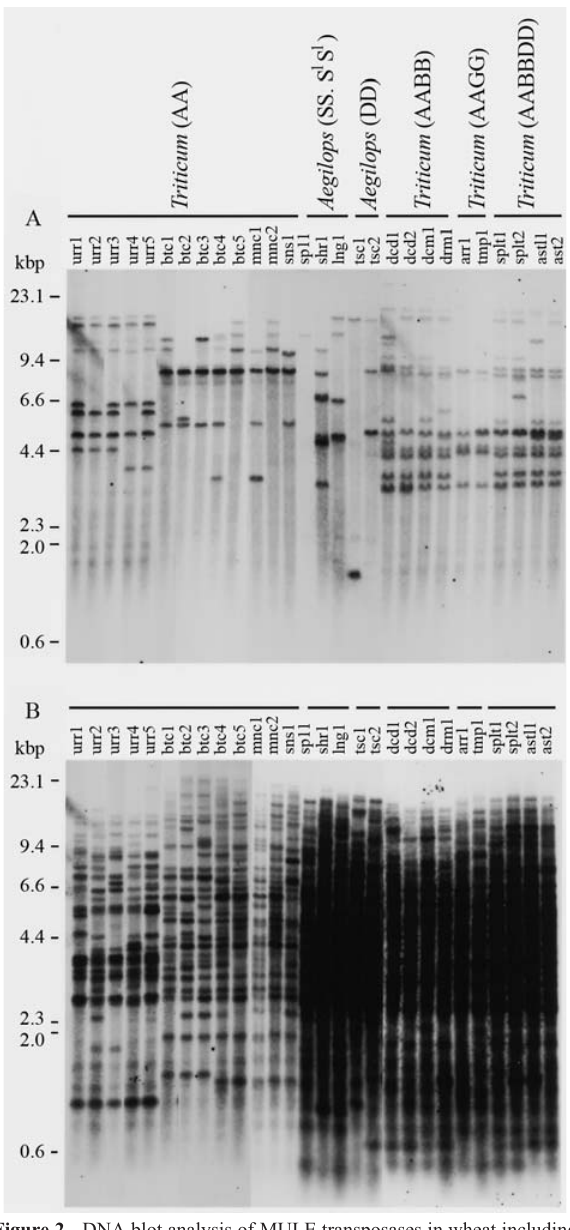
in Table 1. DNA digested with Hin d III was hybridized with the probes: (A) MoTU-32 (subclass I) and (B) MoTU-12 (subclass II).